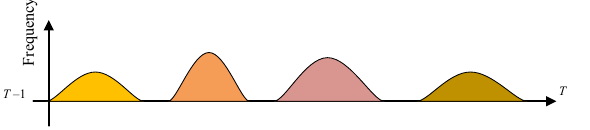
Figure 2. Network attack frequency diagram.